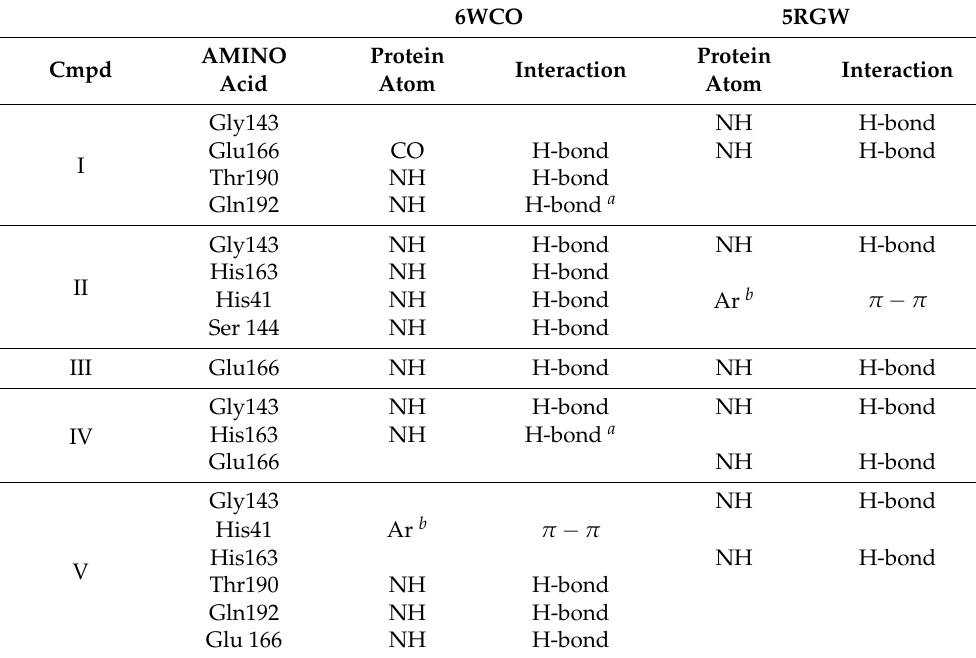
Table 6. Residue analysis of the interaction between putative Mpro inhibitors with 6WCO and